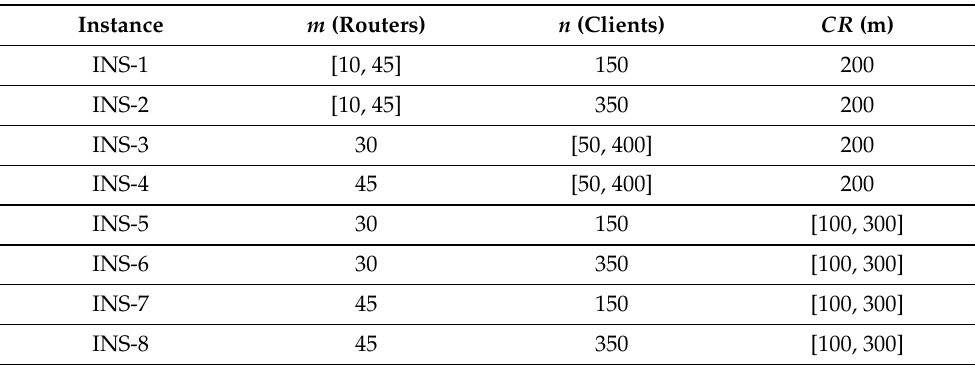
Table 5. Network instance use for